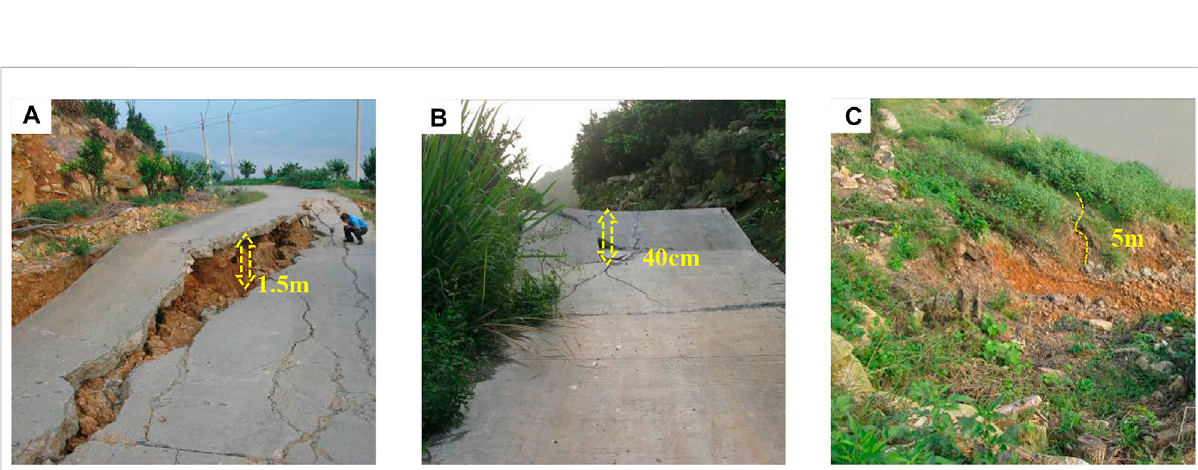
FIGURE 4 Under the in fl uence of heavy rainfall in Zigui (August 31st to 2 September 2014), the landslide surface was seriously deformed. (A) The road was damaged, and the maximum downfall depth was 1.5 m, (B) the road surface was upturned and broken, and (C) the right side of the front edge of the landslide had collapsed and